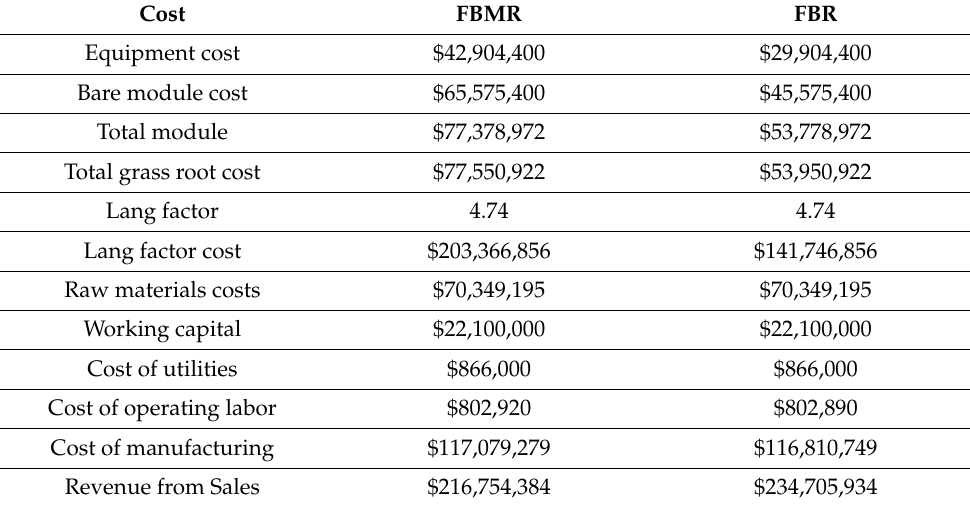
Table 9. Cost comparison of FBMR and FBR.